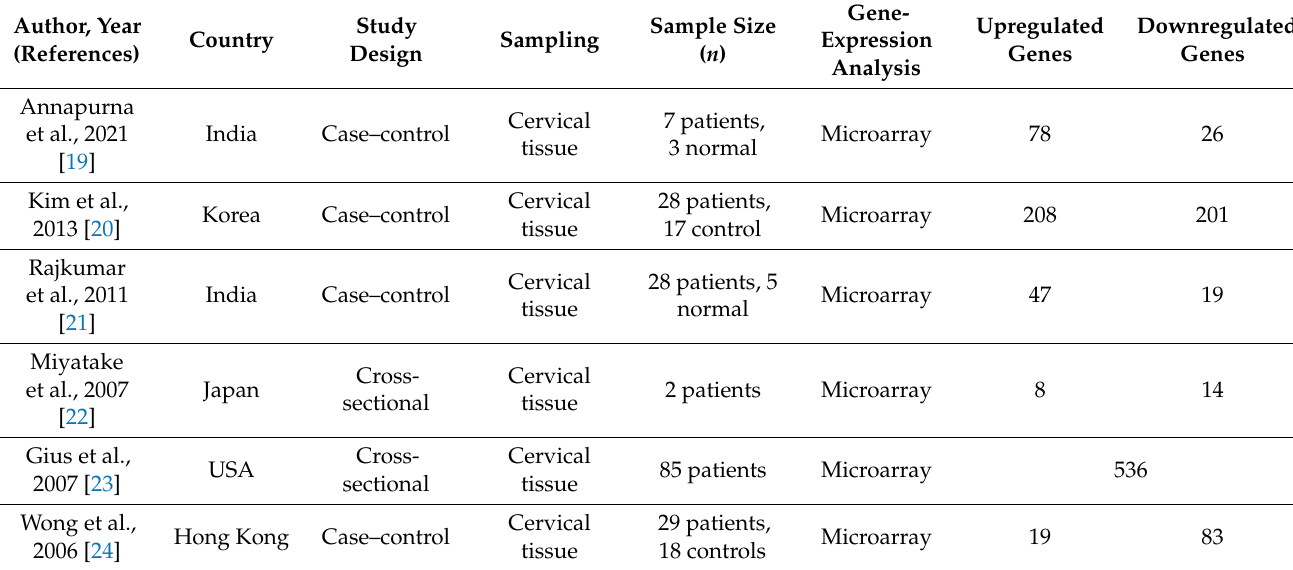
Table 1. Summary of the characteristics of the included